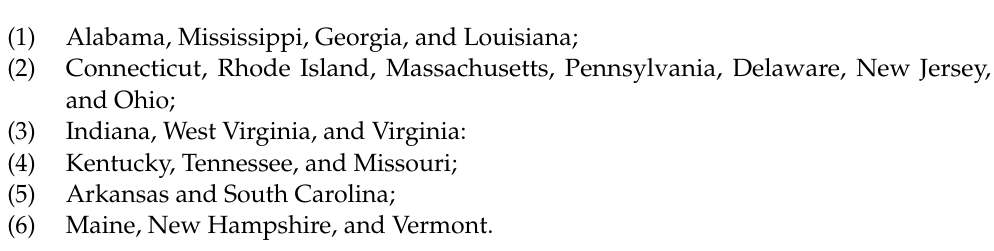
Figure 20. Dendrogram for 12 months.